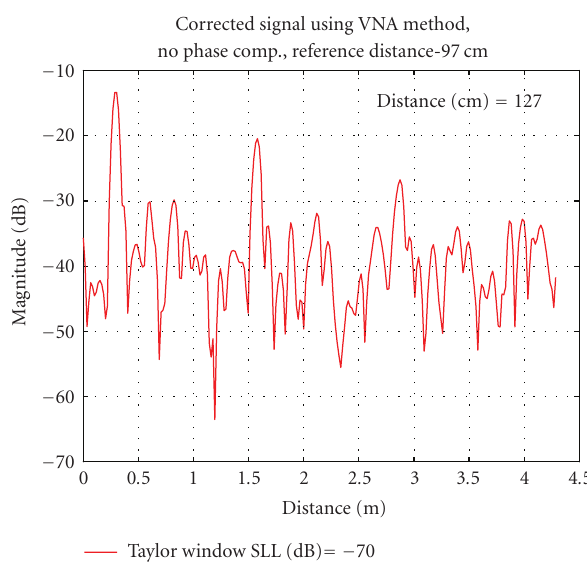
Figure 6: Calibrated A -scan using VNA method; reference distance-97 cm, separation 127 cm.